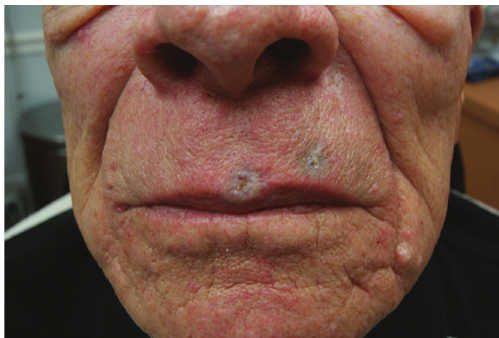
Figure 2: BCCs on the upper mid lip immediately after PDL